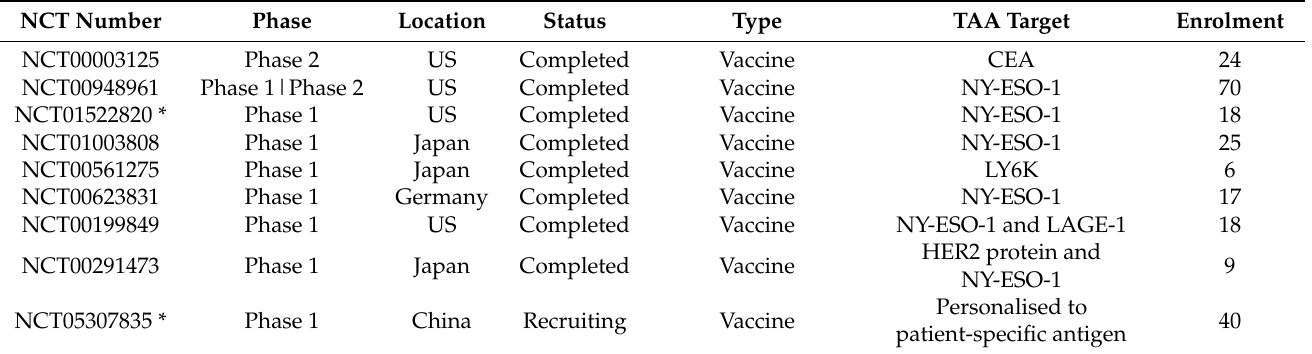
Table 3. Targeting tumour-associated antigen in clinical trials for oesophageal or GOJ cancer from